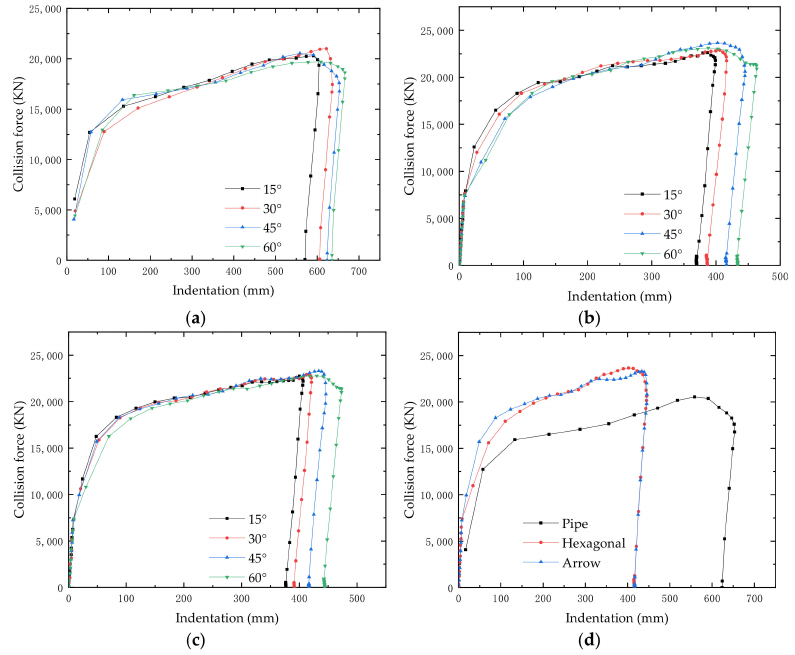
Figure 22. Collision force–indentation curves at different impact angles: ( a ) unreinforced pipe; ( b ) hexagonal honeycomb reinforced pipe; ( c ) arrow honeycomb reinforced pipe; and ( d ) curves of different structures at 45 ◦